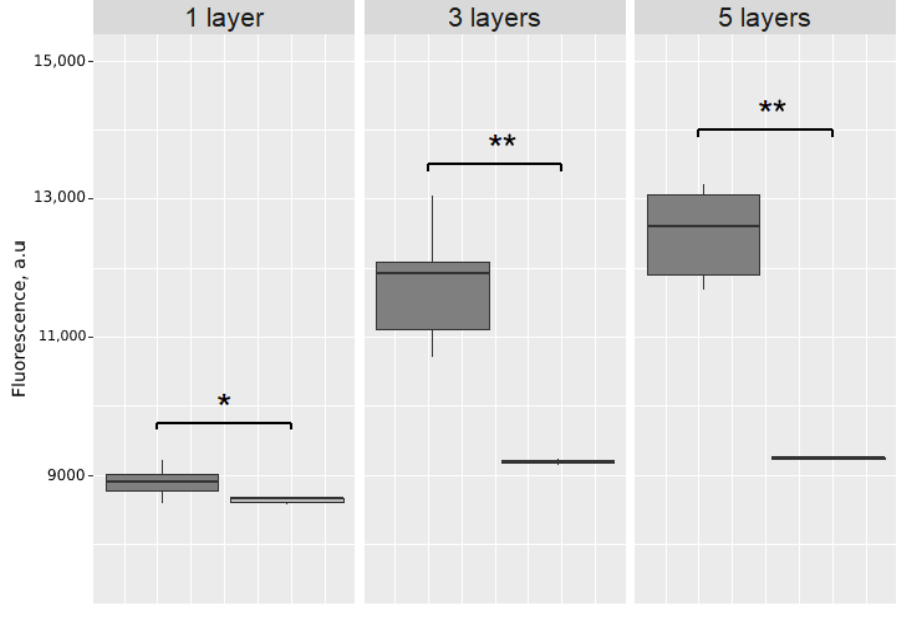
Figure 3. Box plot of the fluorescence intensity after 72 h of incubation of cell-loaded scaffolds (hydrogel with BC cells) and control scaffolds (hydrogel only) printed in one, three or five layers. * p < 0.01, ** p < 0.01.